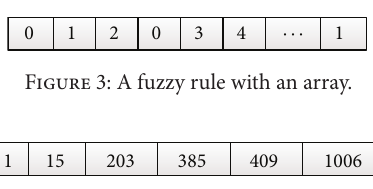
Figure 4: An array containing a subset of attributes index.